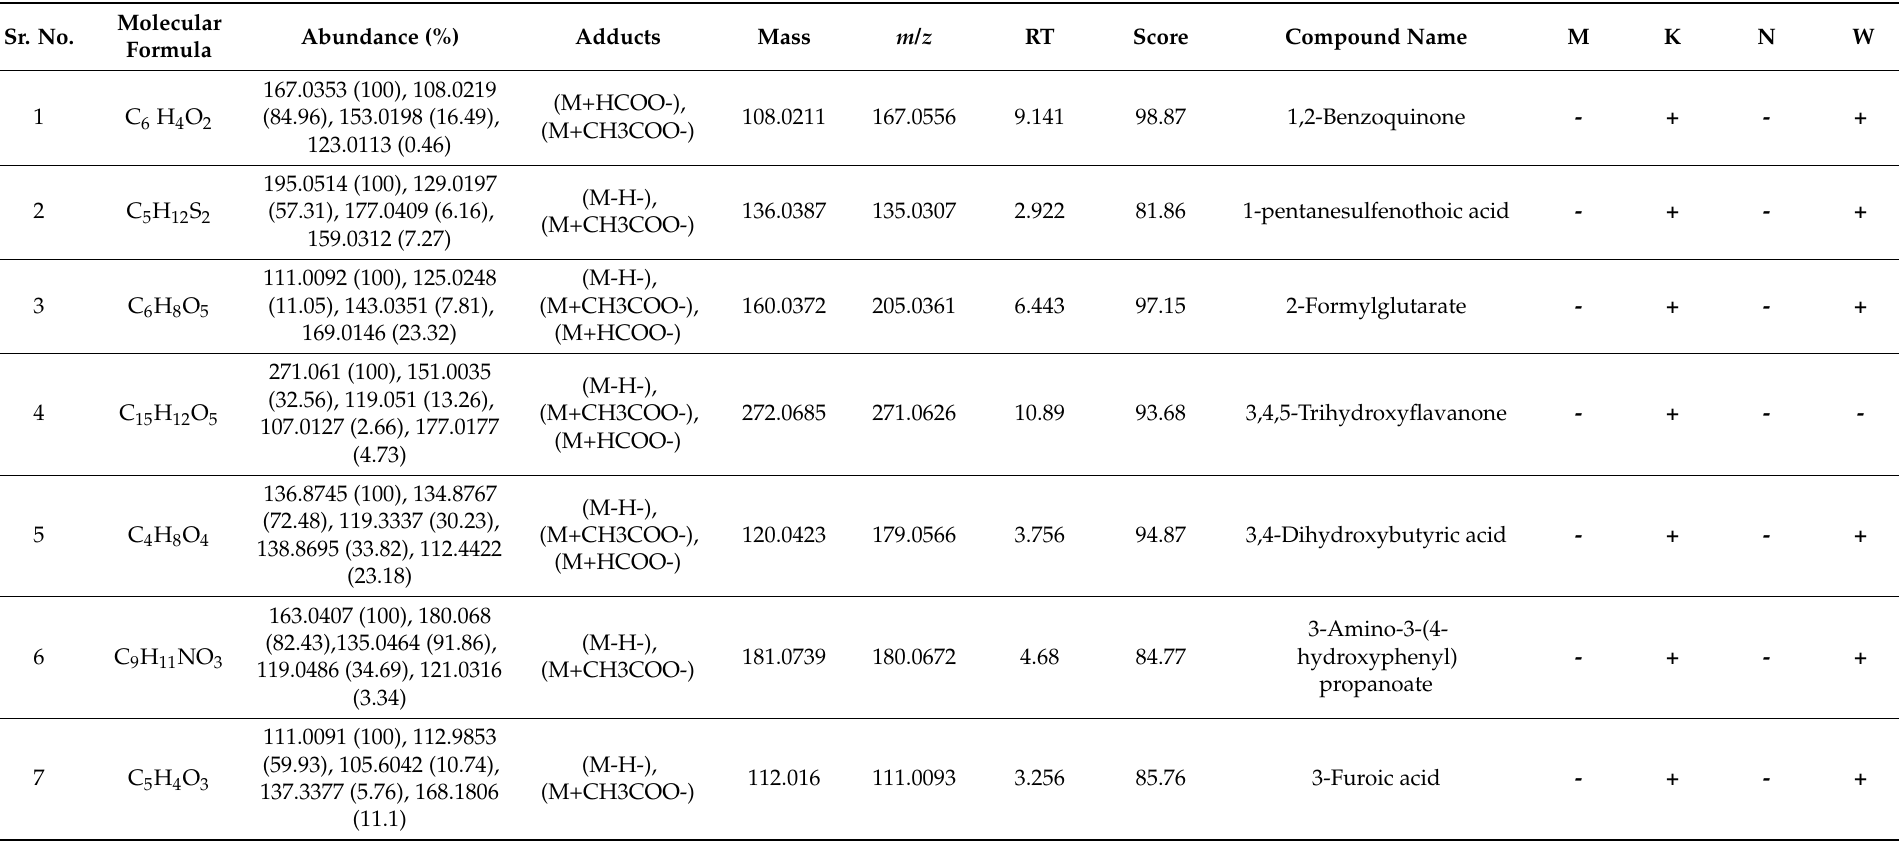
Table 1. Compounds identified from different Embelia accessions by LC-MS/MS. Total of 36 compounds were identified based on the fragment ion spectra in both negative and positive ionization modes. 1–33 in negative ionization mode and 34–36 in positive ionization mode (M—Manoli, K—Kodkani, N—Nadpal,